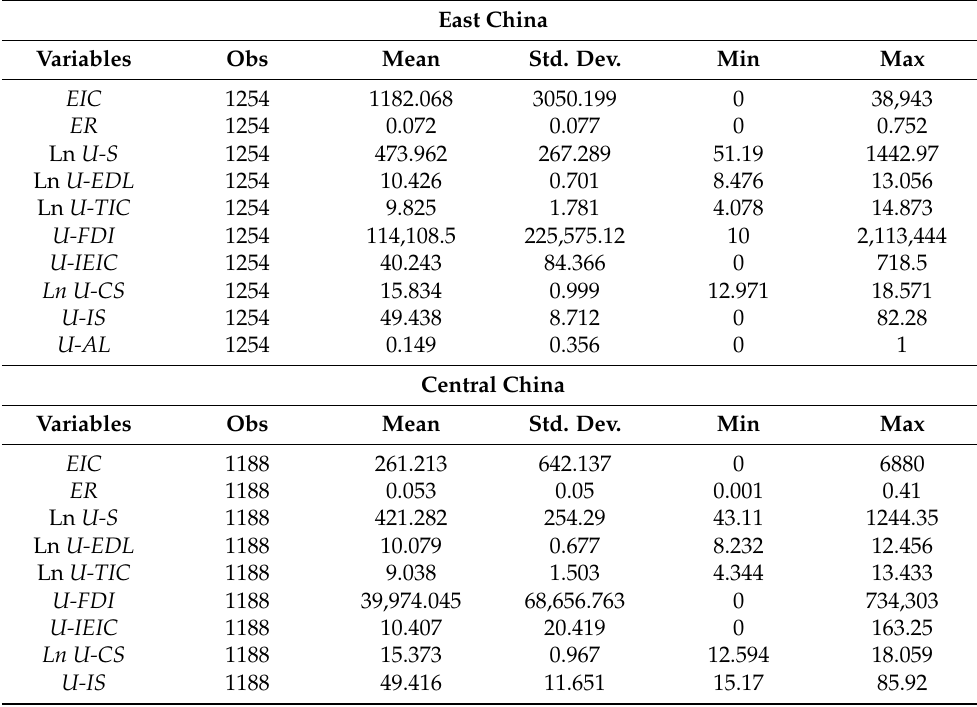
Table 7. Descriptive statistics for panel data of cities in three major regions of